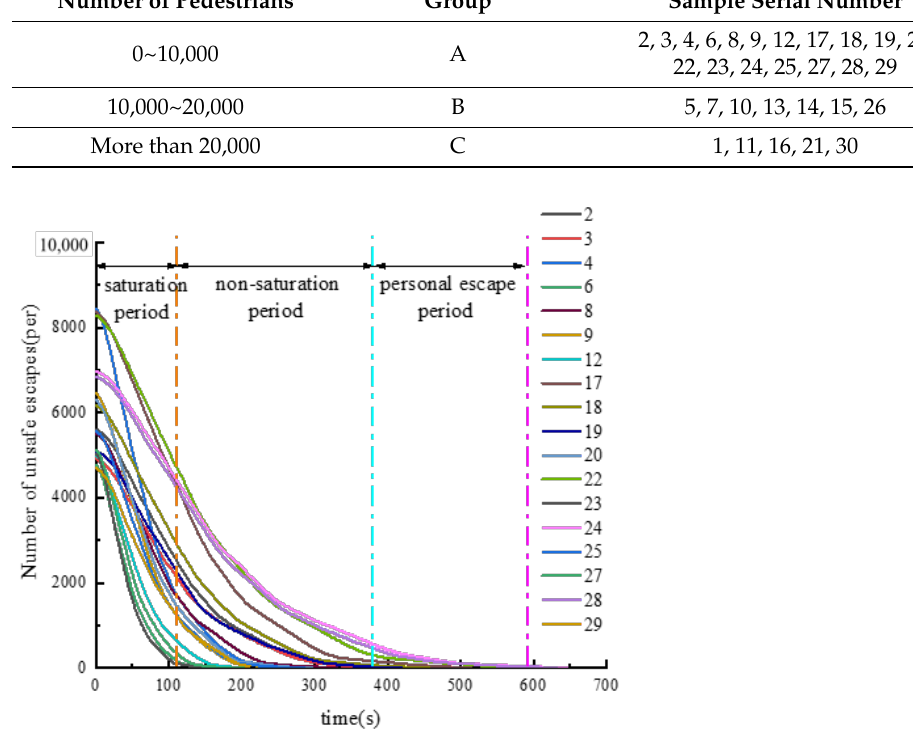
Figure 12. The curve of the number of pedestrians who failed to escape in group C with time. Figures 10 – 12 show that all the curves basically show a concave change; that is, with the increase of time, the number of pedestrians fleeing the subway station per unit of time is gradually decreasing. A 3D visualization of the escape was performed (Figure 13). Ac- cording to the changing form of the curve, pedestrian escape is divided into three periods: saturation period, non-saturation period, and personal escape. For example, within 0~110 s (saturation period) of the samples in group A, all the curves basically decline linearly, and the flow of the pedestrian at all exits in the subway reaches the maximum value at this time. The exit of the passage is in a saturated state, and a large number of pedestrians gather at the exit to escape (Figure 14a), resulting in congestion. Within 110~380 s (half- saturation period), the slope of the curve decreases. At this time, the pedestrian flow at each exit is relatively small (Figure 14b), and some exits have even been idle, and no one has passed. Within 380~590 s (personal escape period), the evacuation of pedestrians in the subway has basically been completed, and only a few pedestrians who are injured or have a slow walking speed are left to escape slowly.